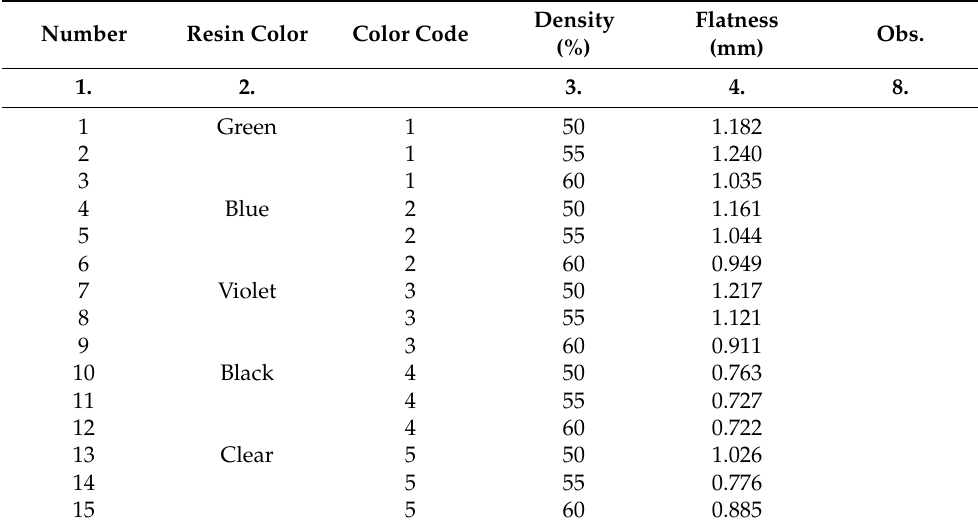
Table 6. The output data for the flatness of the printed part.